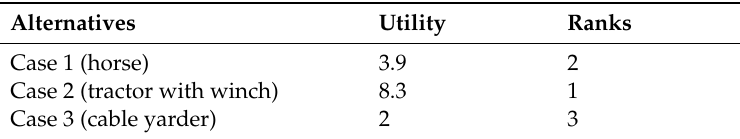
Table 10. MCDA results for application of MAUT method.